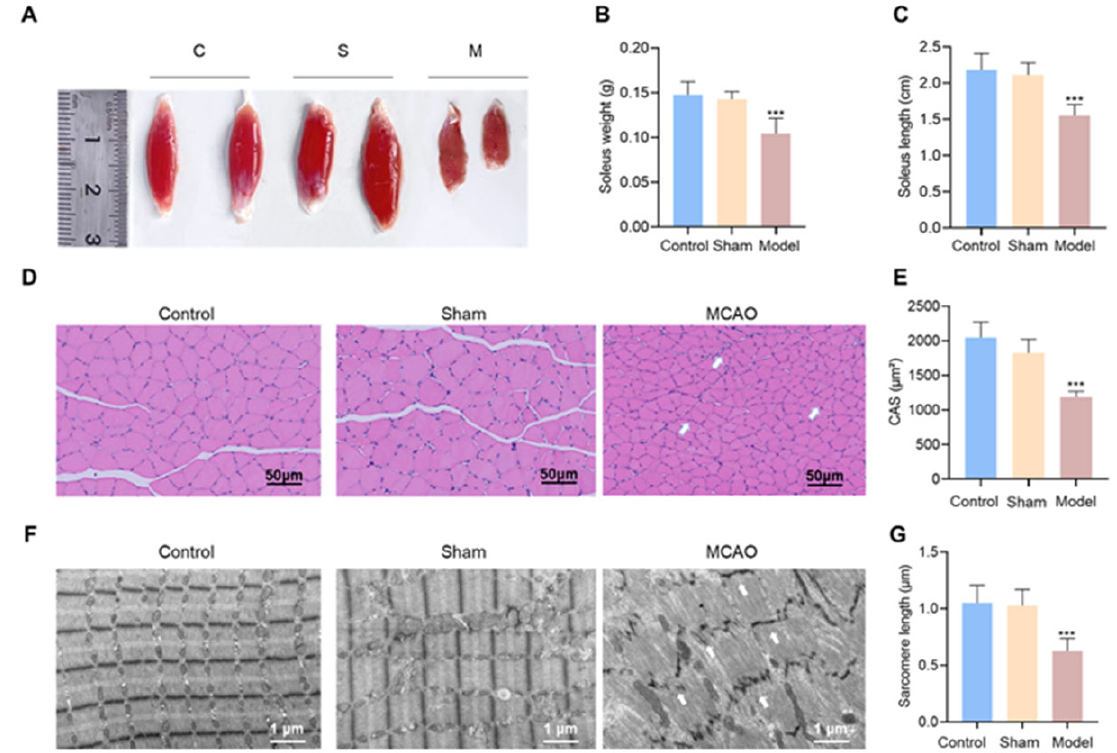
Figure 2. Pathobiological changes in the right hind limb soleus muscle on the affected side of MCAO rats. ( A ) Representative images of the soleus muscle of affected lower limb of rats. ( B ) Weight of affected soleus muscle. ( C ) Length of the affected soleus muscle. ( D ) Representative pictures and analysis of H&E staining of the rat soleus muscle ( n = 6). ( E ) Cross ‐ sectional area of muscle fibers in the same area of the rat soleus muscle, same field of view (200×). ( F ) The representative images for TEM detection of cardiac ultrastructure were shown. ( G ) Analysis of soleus sarcomere length. C, control, S, sham, M, MACO, CAS, Cross ‐ sectional area, *** p < 0.001 vs. the control group. H&E, hematoxylin, and eosin, TEM, transmission electron microscopy.